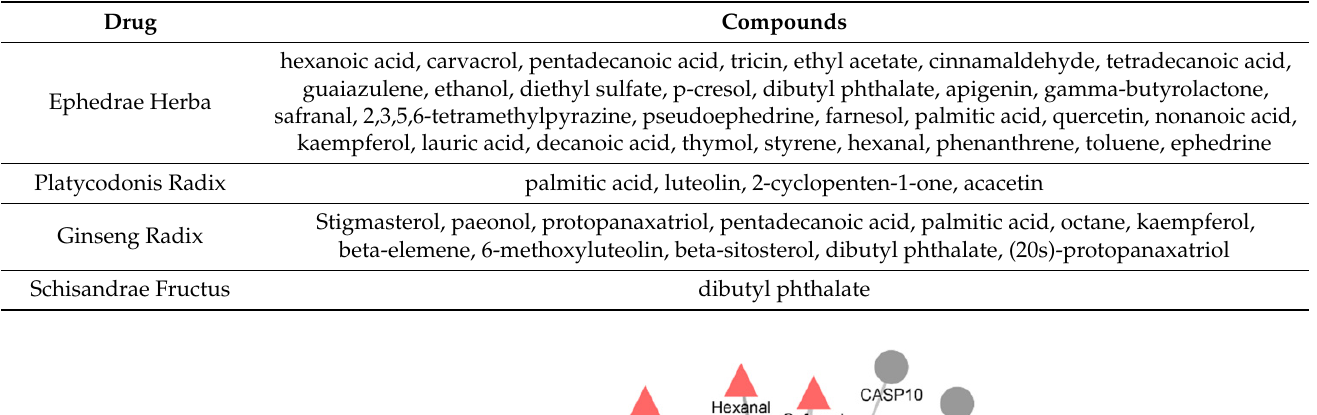
Table 6. Bioactive compounds predicted to interact with the proteins associated with TNF- α , NF- κ B, and calcium signaling pathways.